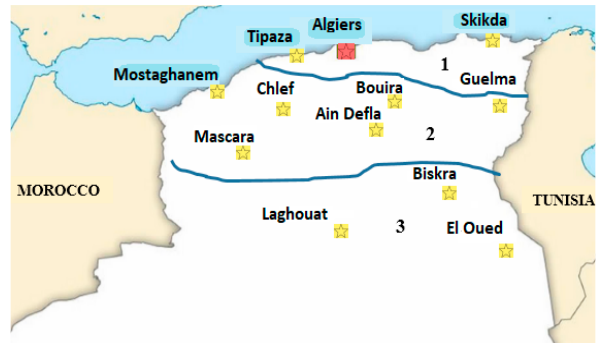
Figure 1. Geographic localities in the different bioclimatic areas: 1 = Mediterranean climate, 2 = semi-arid climate, 3 = arid climate